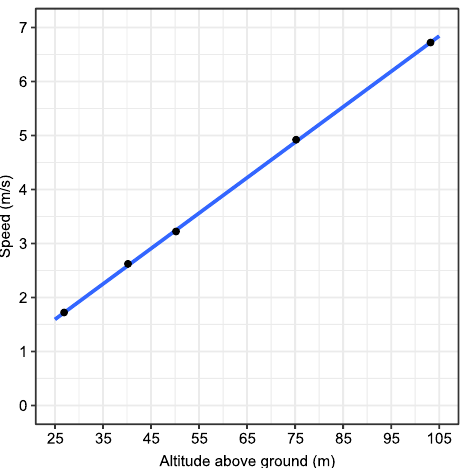
Figure 3. Relationship of the altitude above ground and the corresponding speed that was calculated by the flight planning software. Equation and regression coefficients in Supplementary Table S1.